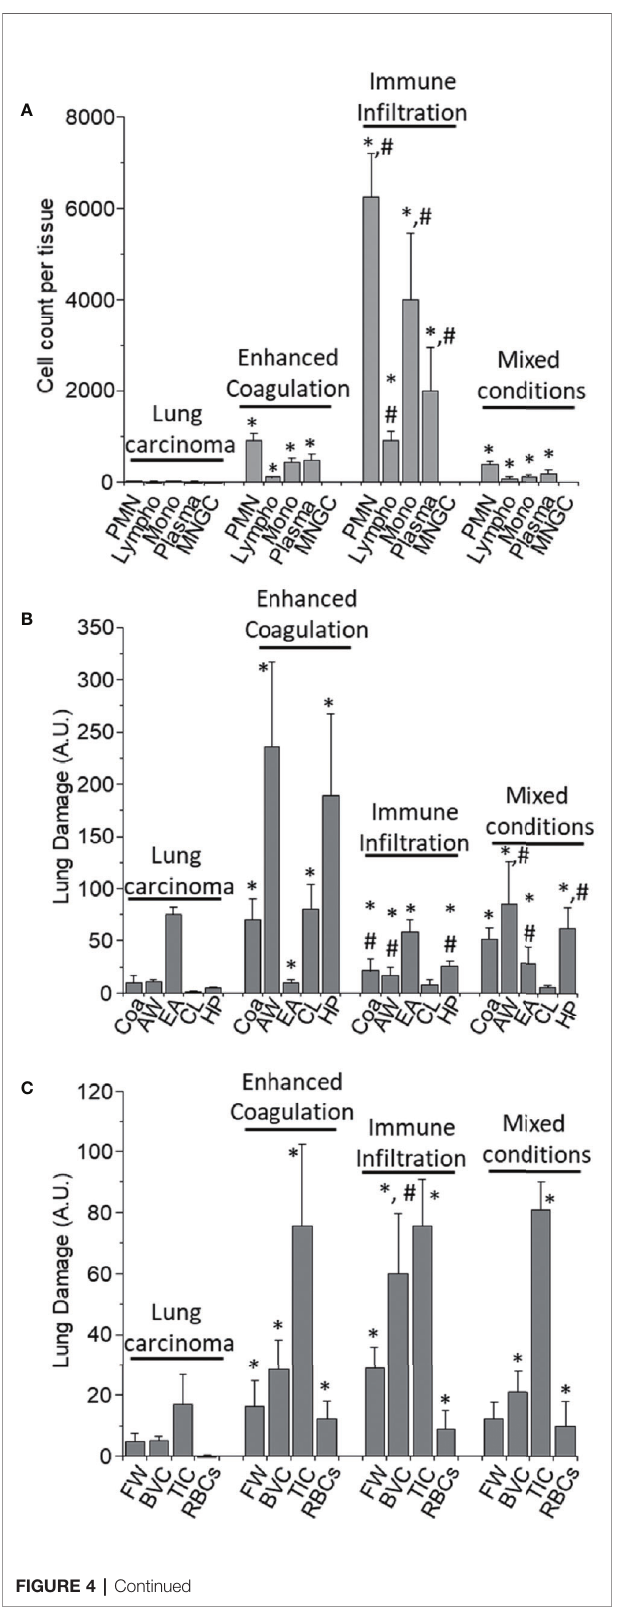
of in fl ammatory and growth factor products to repair and renew the lung (59 – 61). To evaluate the SMC distribution and numbers, we performed staining for the nucleus (DAPI, blue